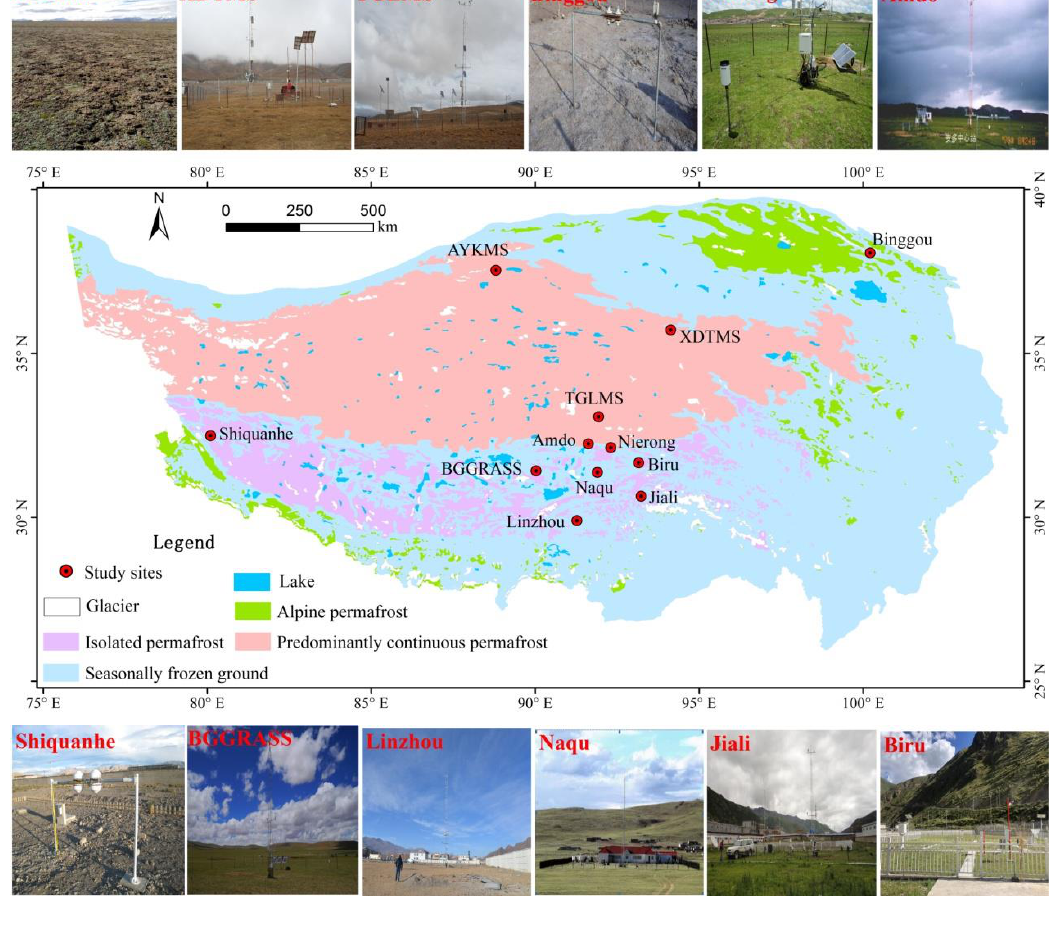
Figure 1. Distribution of study sites on the Tibetan Plateau (source of permafrost distribution data: [25]) For abbreviations of site names and further details see Table 1.